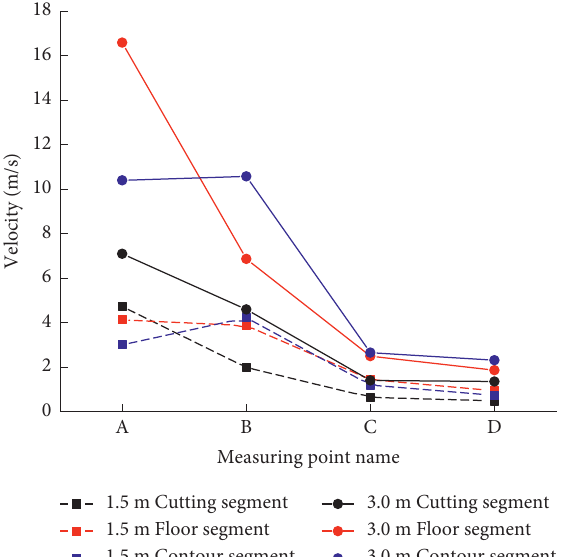
Figure 10: Comparison of the vibration velocity of typical blasting segments with different footage conditions at the monitoring points A, B, C, and D.